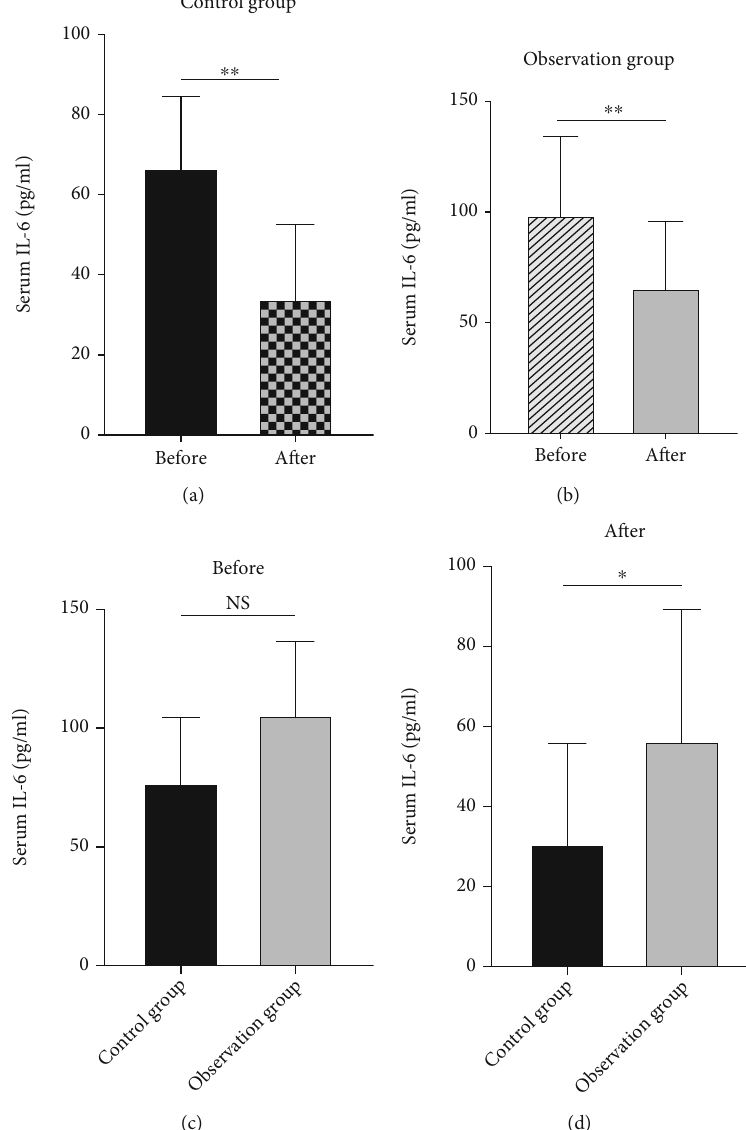
Figure 4: Analyze the changes of IL-6 protein expression before and after treatment in the two groups, observation group (a) and control group (b). Reanalysis of the protein expression level of IL-6 before treatment between the two groups was not statistically signi fi cant, proving that the two are comparable (c). Comparing the IL-6 levels of the two groups of patients after treatment, it was found that the protein expression level of the observation group was lower than that of the control group, and the di ff erence was statistically signi fi cant (d) ( n = 30 , ∗∗ p < 0 : 01 , ∗ p < 0 : 05 , NS: no signi fi